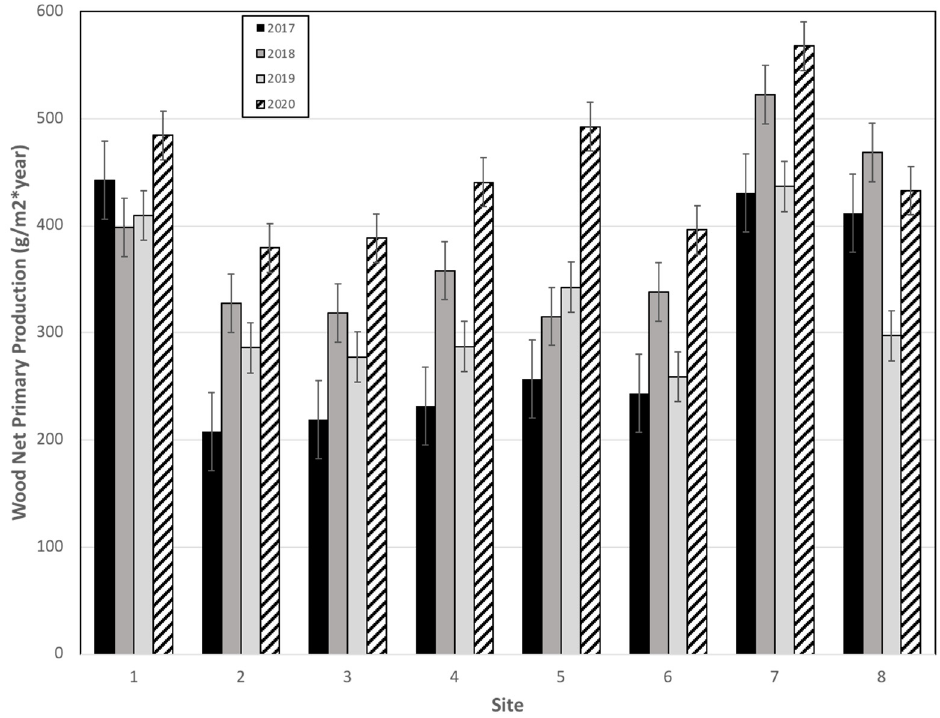
Figure 7. Net primary production (gm m − 2 y − 1 + s.e.) for Sites 1–8 for 2017 (black), 2018 (dark gray), 2019 (light gray), and the 2020 (striped) growing seasons.